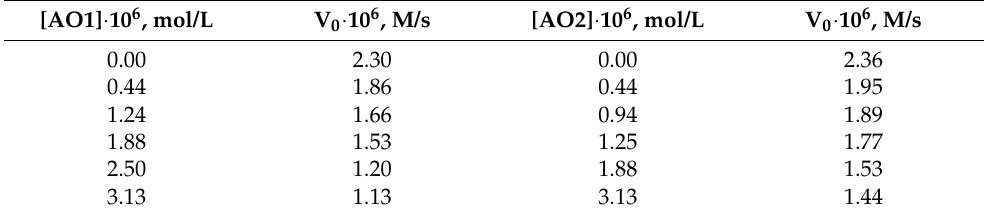
Table 5. Dependence of the initial oxidation rate of ethylbenzene on the concentration of AO1 and AO2; V i = 1 × 10 − 7 M/s, T = 348 K.